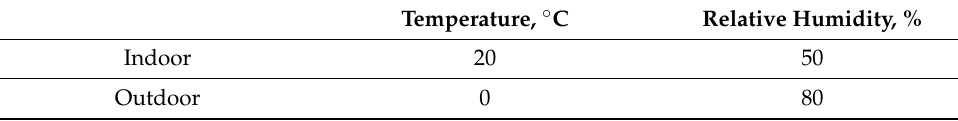
Table 9. Average indoor and outdoor conditions for